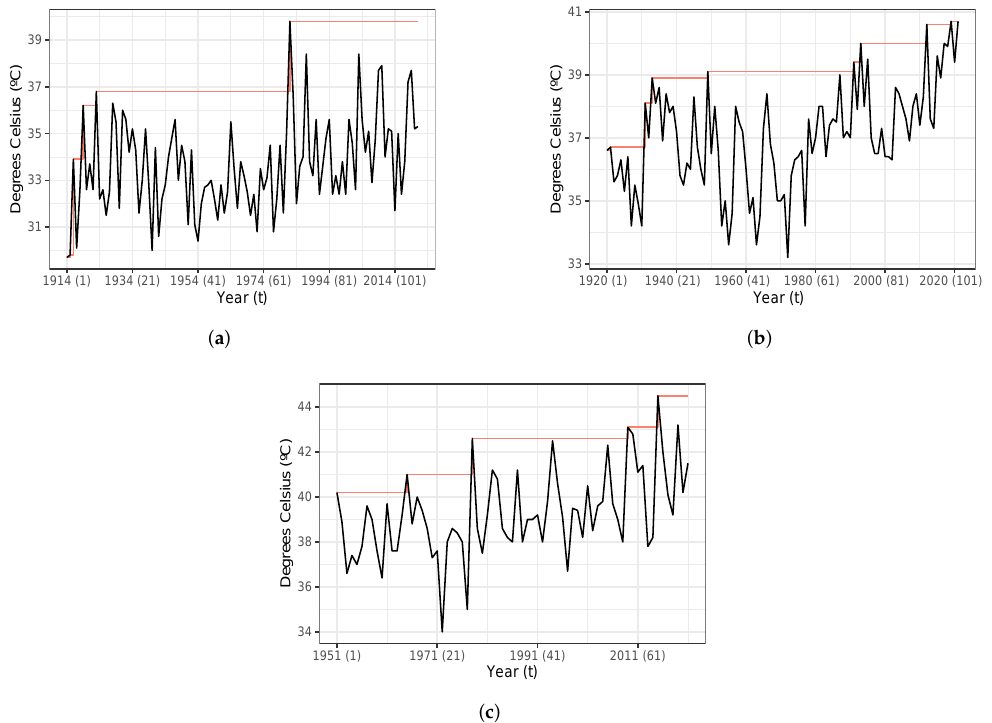
Figure 3. Annual maximum temperature series and their records. ( a ) Barcelona (1914–2021). ( b ) Madrid (1920–2021). ( c ) Zaragoza